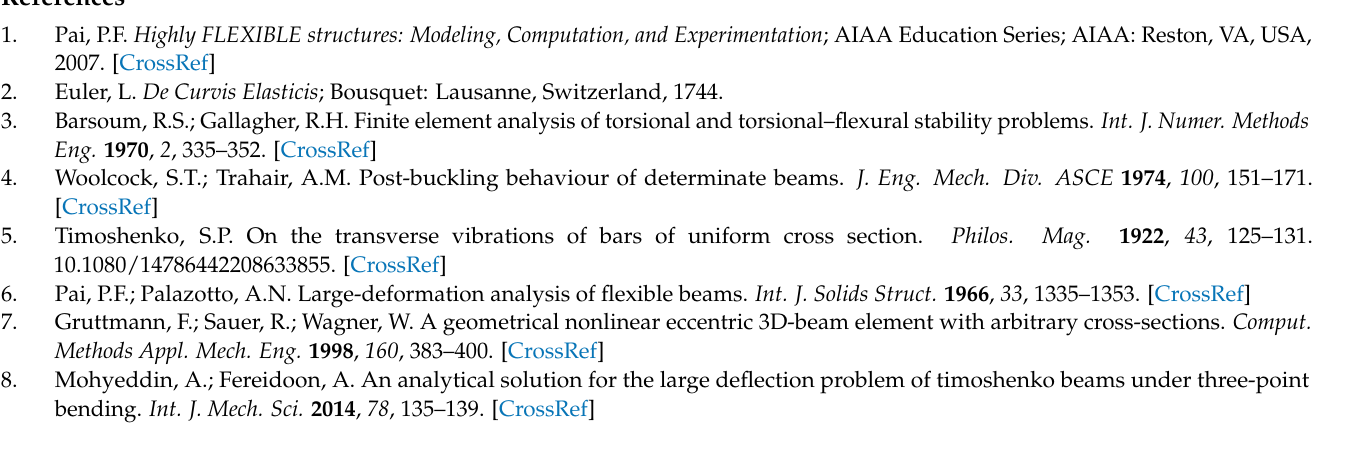
and σ ∗ yz = σ yz / σ yz max max